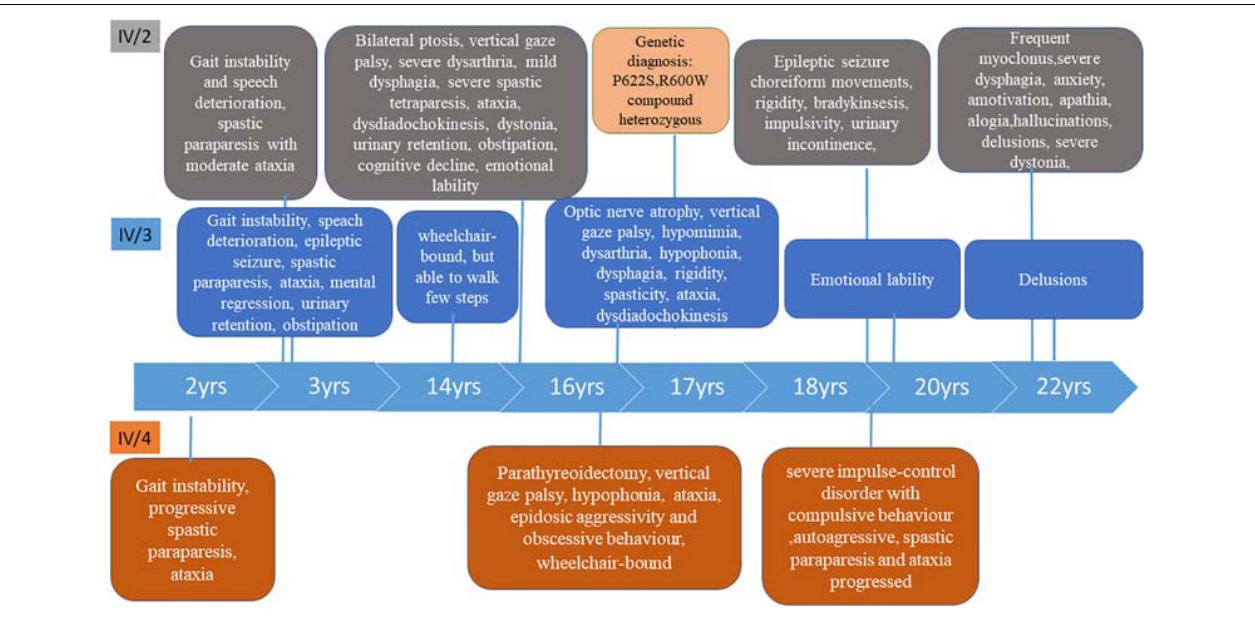
FIGURE 2 | Timeline of the clinical symptoms in the three patients.